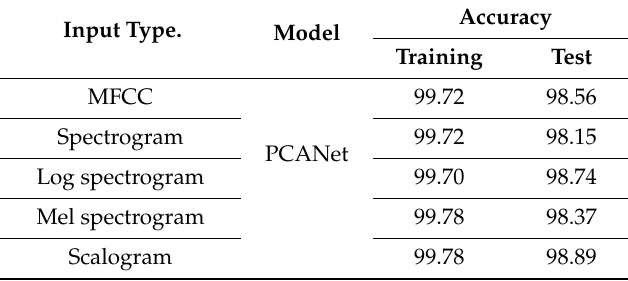
Table 2. Accuracies achieved by PCANet using time-frequency representations on PTB-ECG.